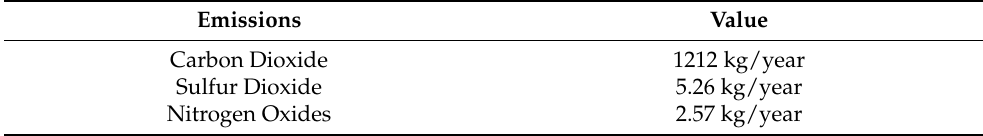
Figure 13. Average monthly PV system output power.